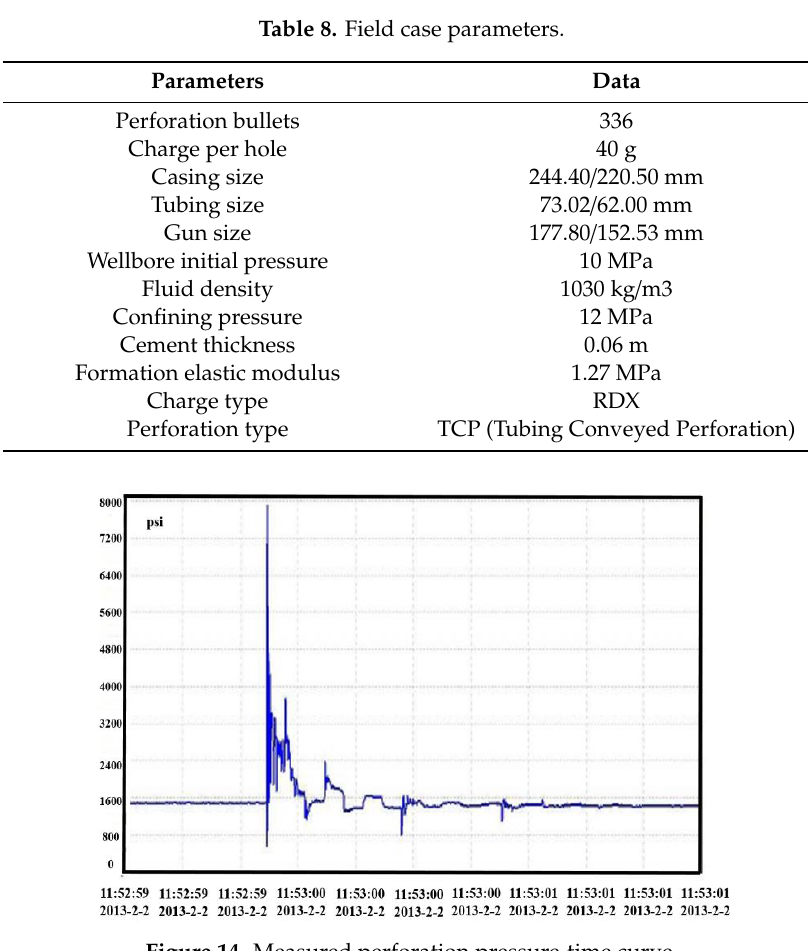
Table 9. Calculation results of different empirical formulas.